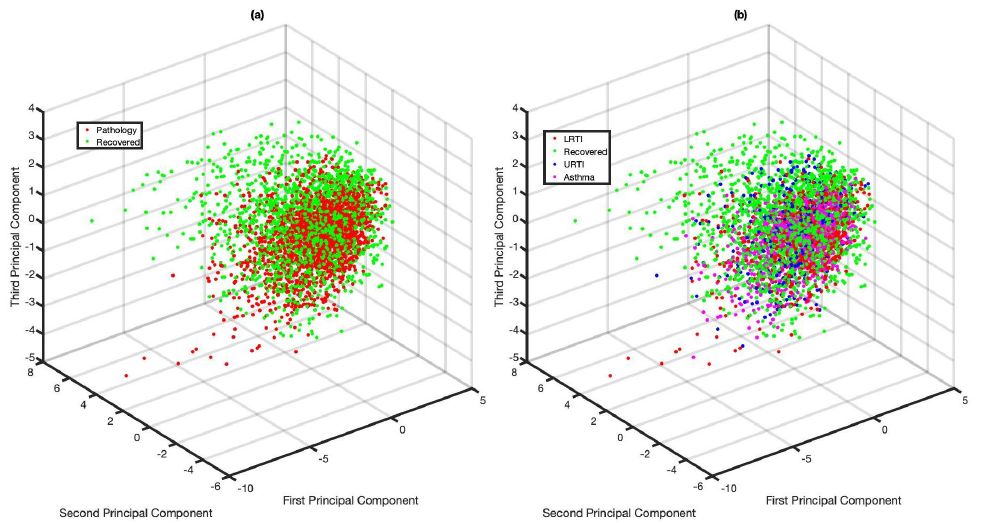
Figure 5. MFCC feature evolution from pathological to recovery. The plot is created after transform- ing the original 42 dimensions into three using PCA: ( a ) Recovered vs. Pathology, ( b ) Recovered vs. LRTI vs. URTI vs. Asthma.